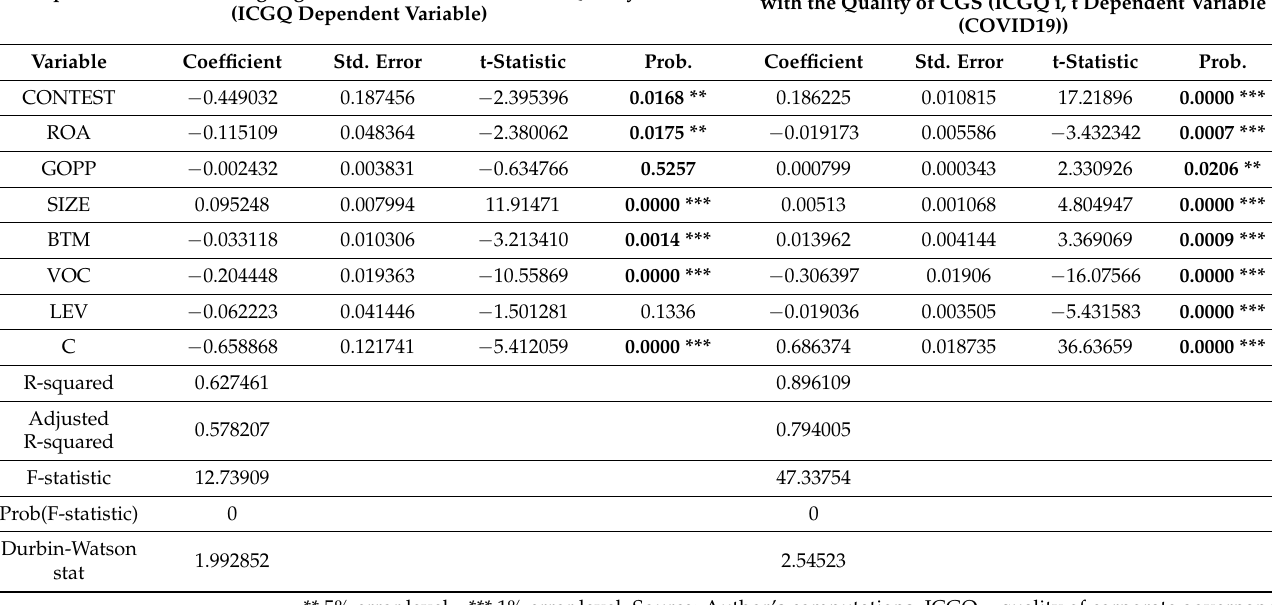
Table 8. Competitiveness and the ratio of voting rights of major shareholders to the quality of the corporate governance system. Panel A Competitiveness and Voting Rights of Shareholders with the Quality of CGS (ICGQ Dependent Variable)